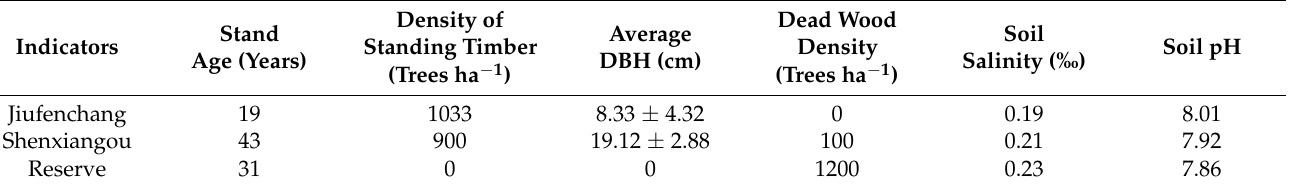
Figure 1. Geographical location of the study sites. A: Shandong Yellow River Delta National Nature Reserve; B: Jiufenchang of Gudao Town; C: Shenxiangou. Table 1. Characteristics of stand structure of Robinia pseudoacacia plantation.